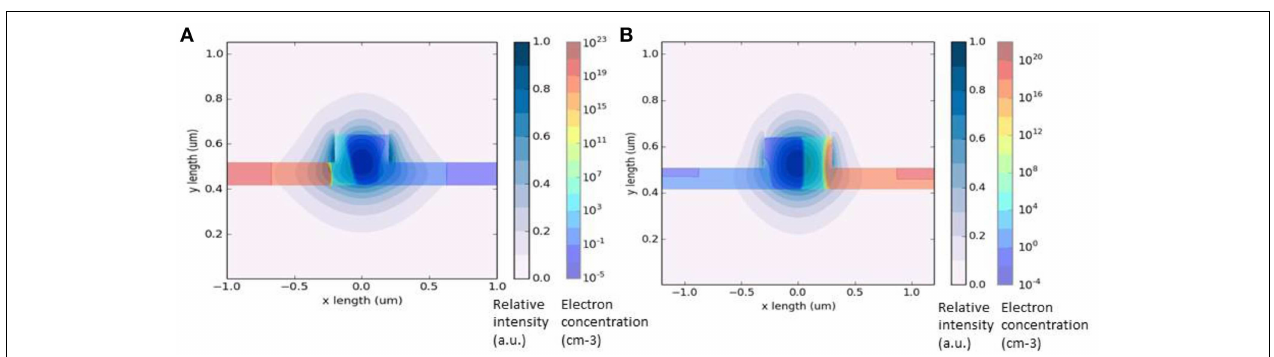
FIGURE 4 | Optical mode profile overlaps with electrical domain (A) mod1 and (B) mod2.